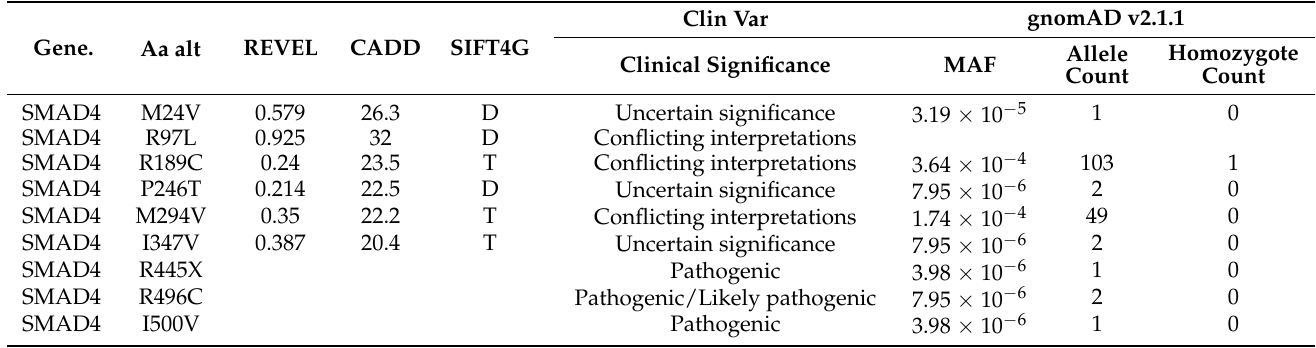
Table 1. Human SMAD4 Genomic Variants Identified by Thoracic Aortic Aneurysm Screening. A list of variants with MAF ≤ 0.001 and CADD score ≥ 20 are included. The ESTAD and HTAD columns denote the number of unrelated cases for each variant. Abbreviations: Alternate amino acid (Aa alt), Rare Exome Variant Ensemble Learner (REVEL), Combined annotation-dependent depletion score (CADD), Sorting Intolerant from Tolerant for Genome (SIFT4G) prediction, Damaging (D), Tolerant (T), Clinical significance of the Variant (ClinVar), Genome Aggregation Database allele frequency (gnomAD exome v2.1.1), early-onset thoracic aortic dissection (ESTAD), and unrelated heritable thoracic aortic disease (HTAD).